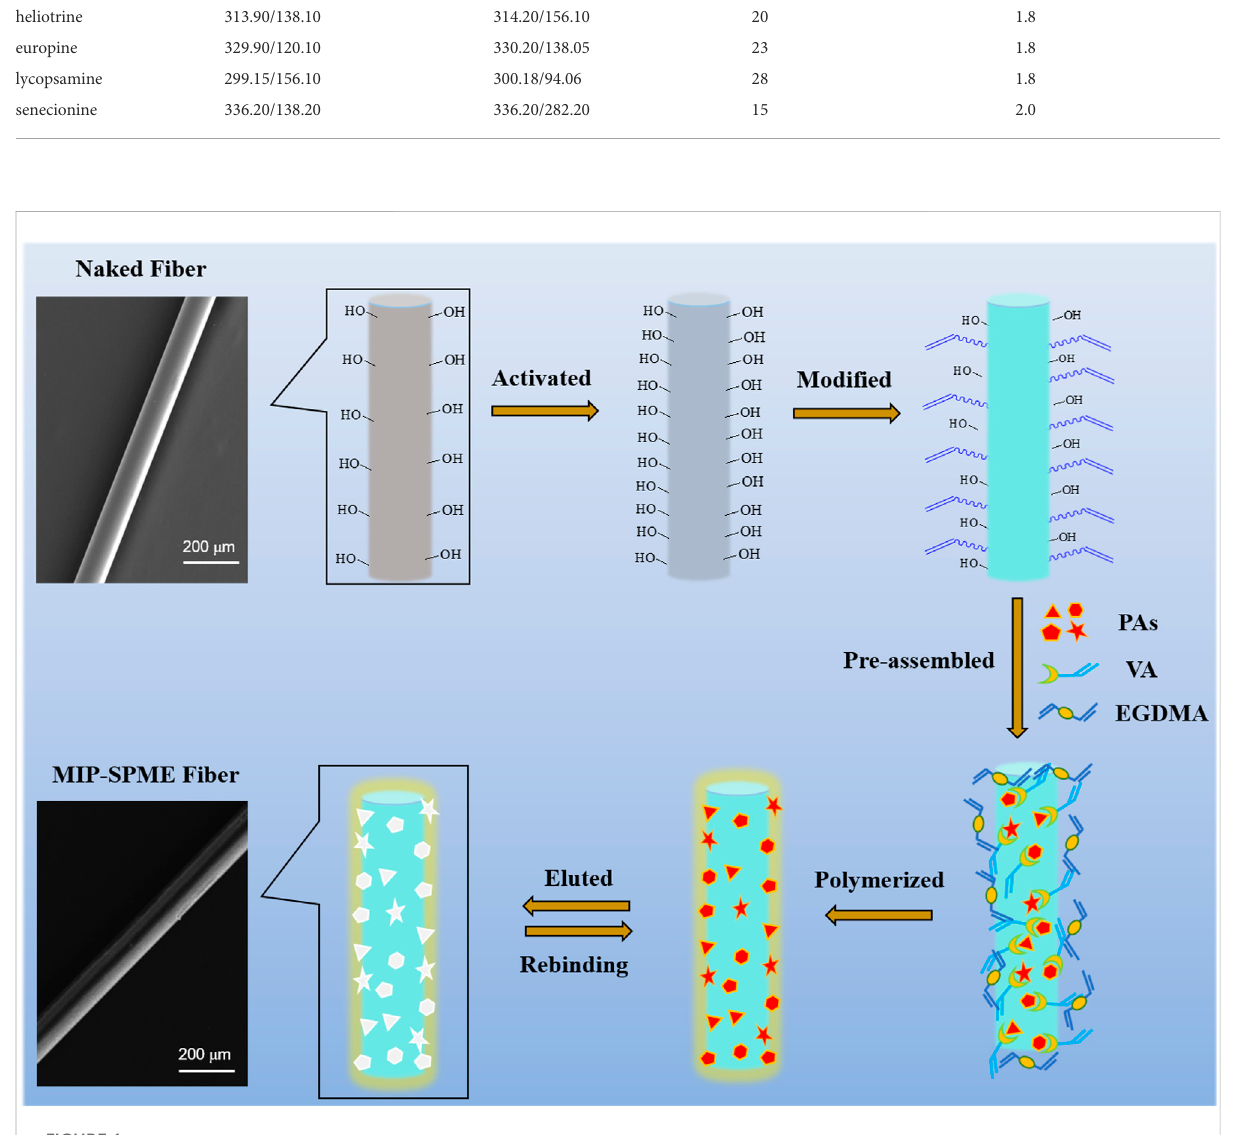
FIGURE 1 The schematic of preparation procedure of MIP-SPME fi